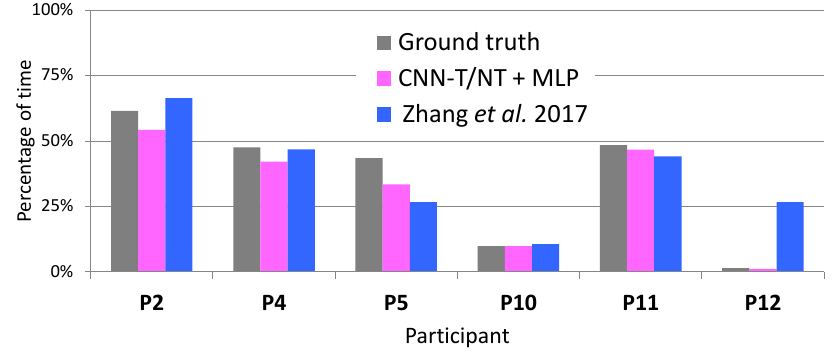
Figure 11. True percentage of tremor (calculated from the accurate labels) and percentage output by the automatic systems on LAB